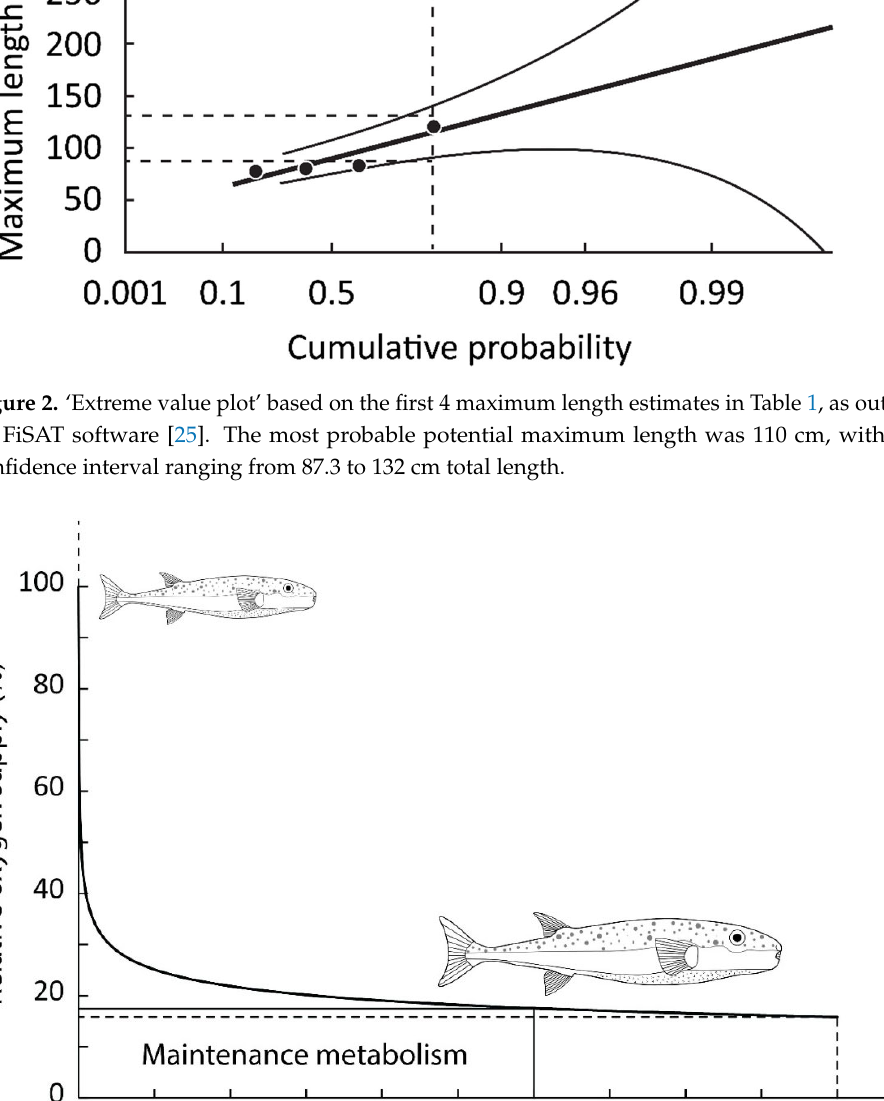
Figure 2. ‘Extreme value plot’ based on the first 4 maximum length estimates in Table 1, as outputted by FiSAT software [25]. The most probable potential maximum length was 110 cm, with a 95% confidence interval ranging from 87.3 to 132 cm total length.